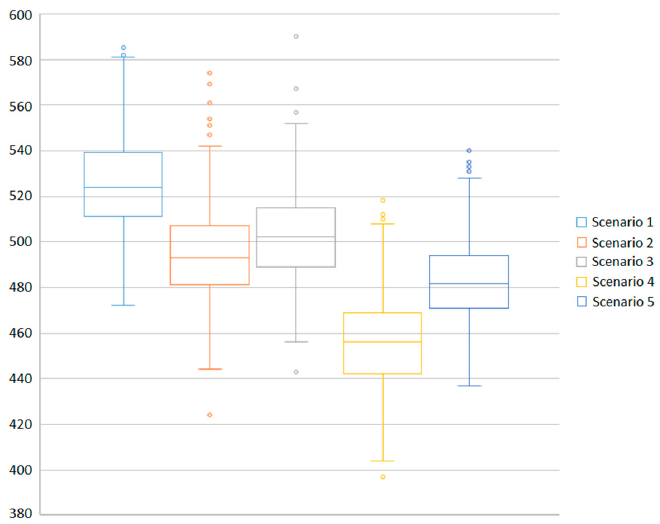
Figure 8. Impact of roundabout traffic organisation on the quantity of cellular automaton (CA) iterations.